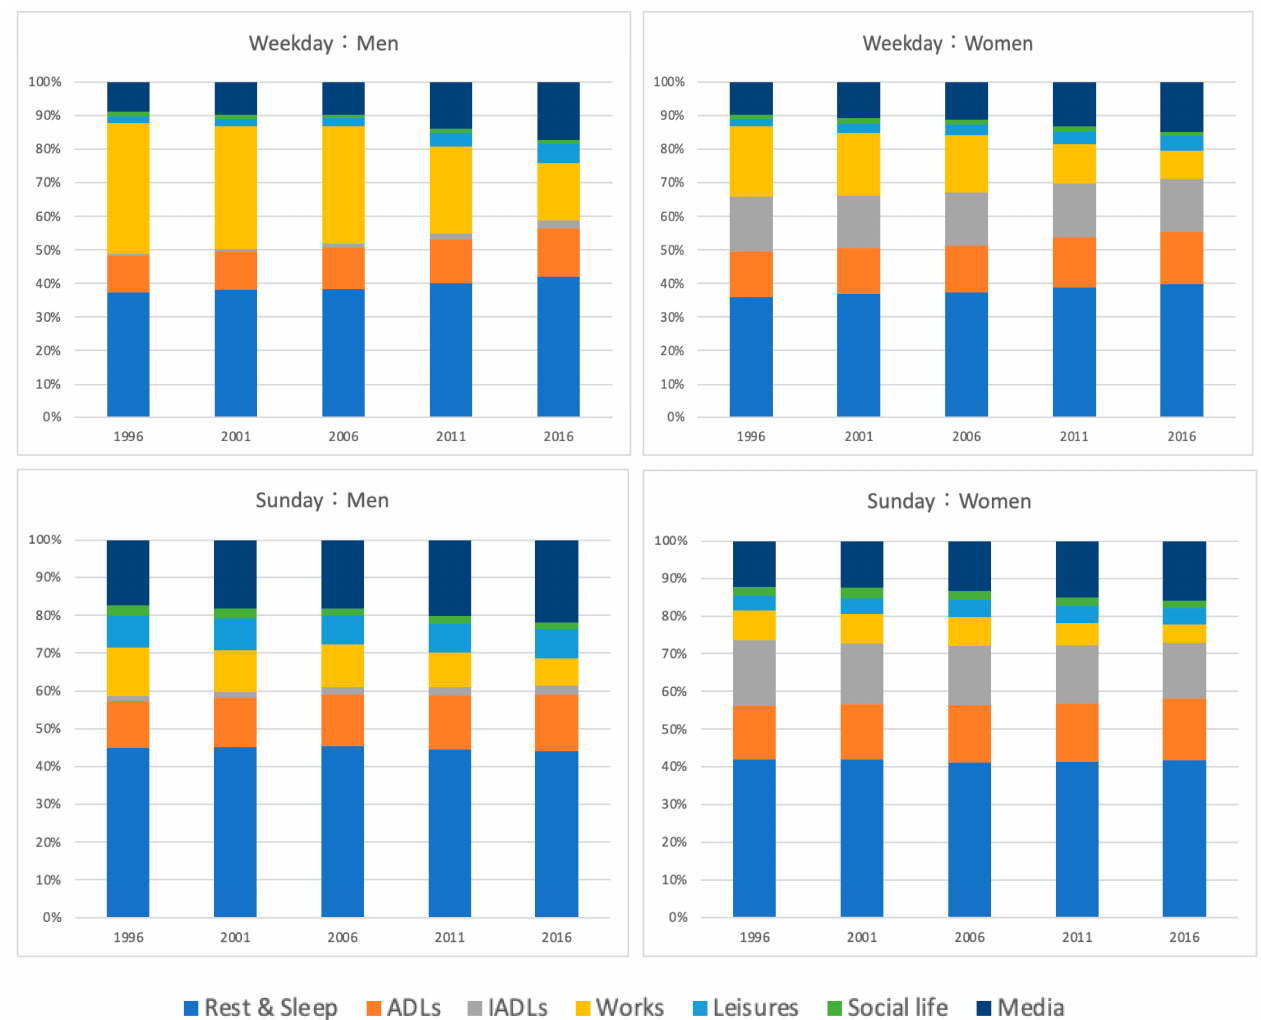
Figure 2. Occupational performance patterns.